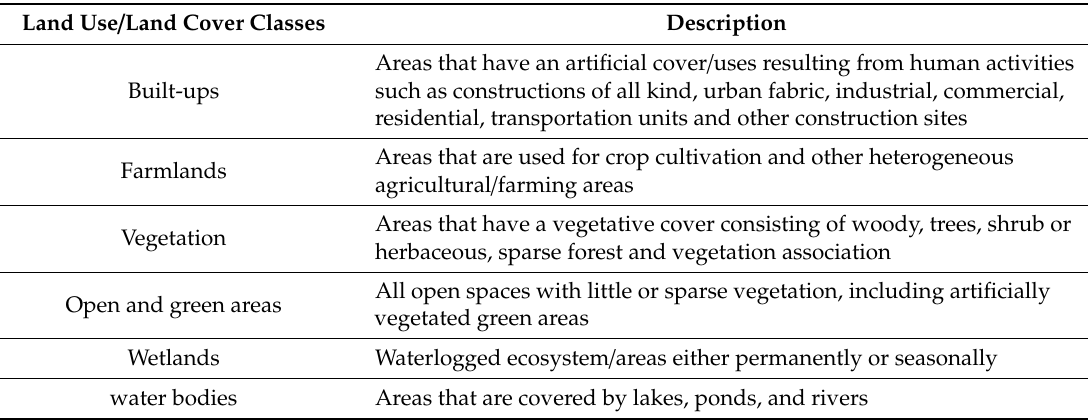
Table 2. Type and description of land use / land cover